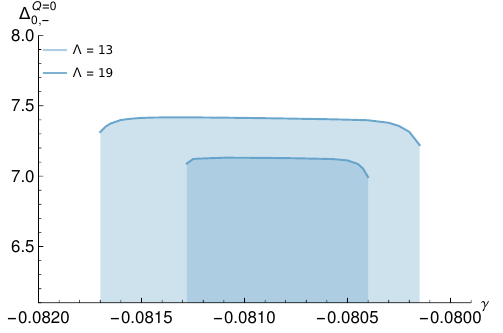
Figure 3 . Upper and lower bound on the central charge C T normalized to the free value assuming the constraints shown in table 1 and ∆ T 0 ≥ 4 . 5 . The bounds have been computed at Λ = 13 .